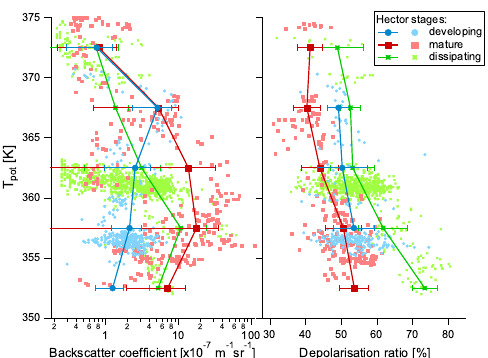
Figure 9. MAS cloud particle backscatter coefficient (left) and cloud particle depolarisation ratio (right). The light coloured mark- ers indicate the individual measurements. Lines and markers repre- sent the averages for the 5K altitude bins as in Fig. 7, with error bars denoting the standard